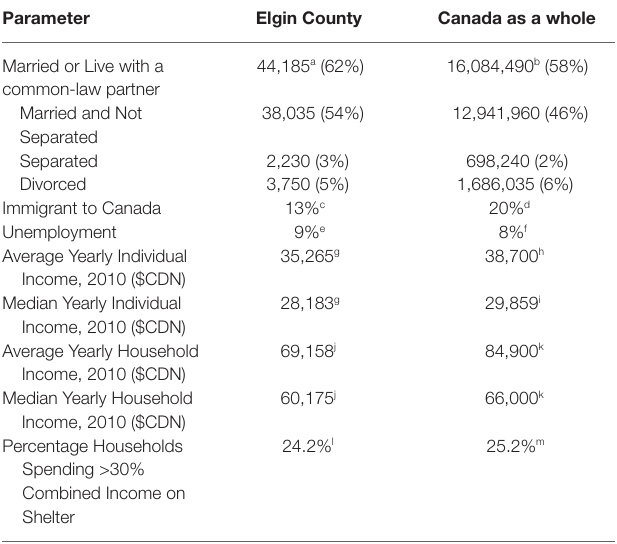
TABLE 1 | Demographic data regarding Elgin County, Ontario, Canada, and Canada as a